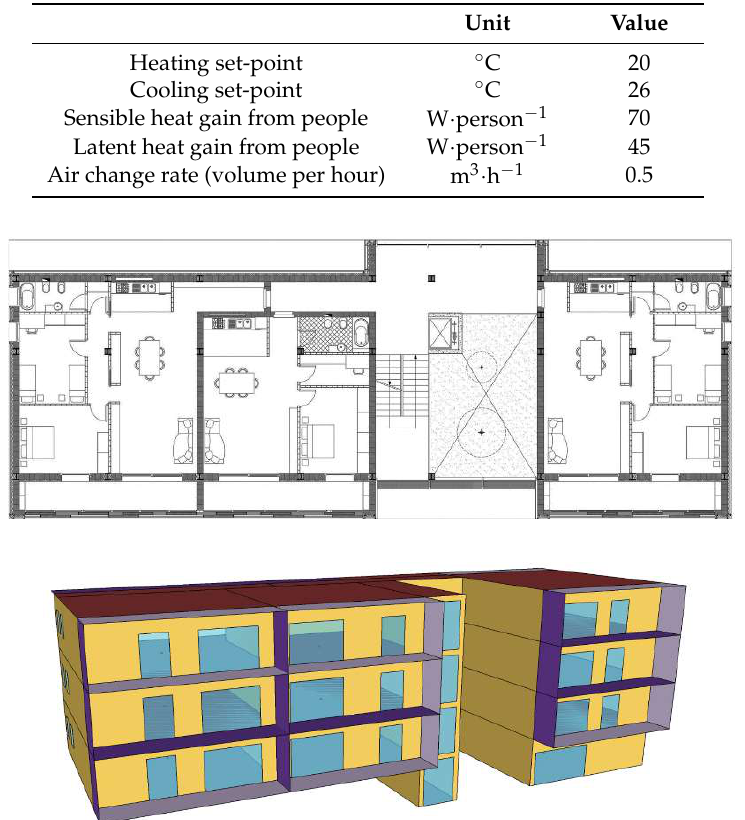
Figure 1. Plan of one floor and a three-dimensional (3D) model of the building analyzed.